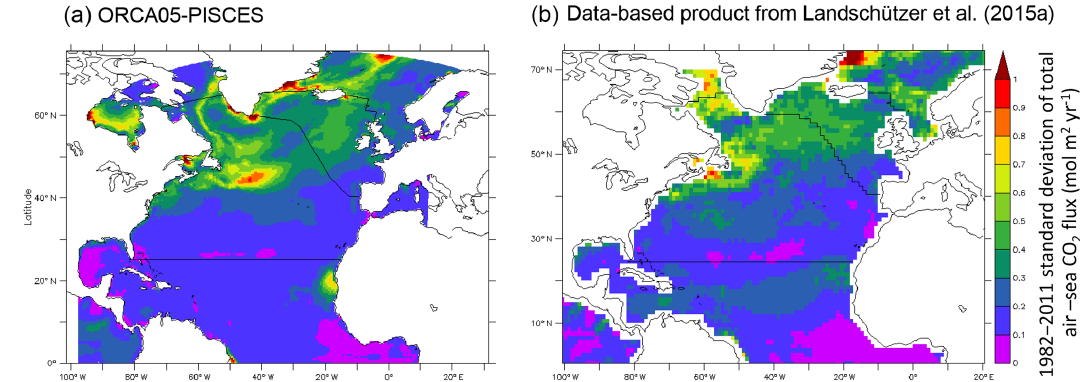
Figure 9. Interannual variability of air–sea flux of total CO 2 (molm 2 yr − 1 ) for the period 1982–2011: (a) model output and (b) observation- based estimate (Landschützer et al., 2015a). Black lines indicate borders of boxes 25 ◦ N–OVIDE and OVIDE–sills. Interannual variability corresponds to the standard deviation computed from the time series of air–sea fluxes.